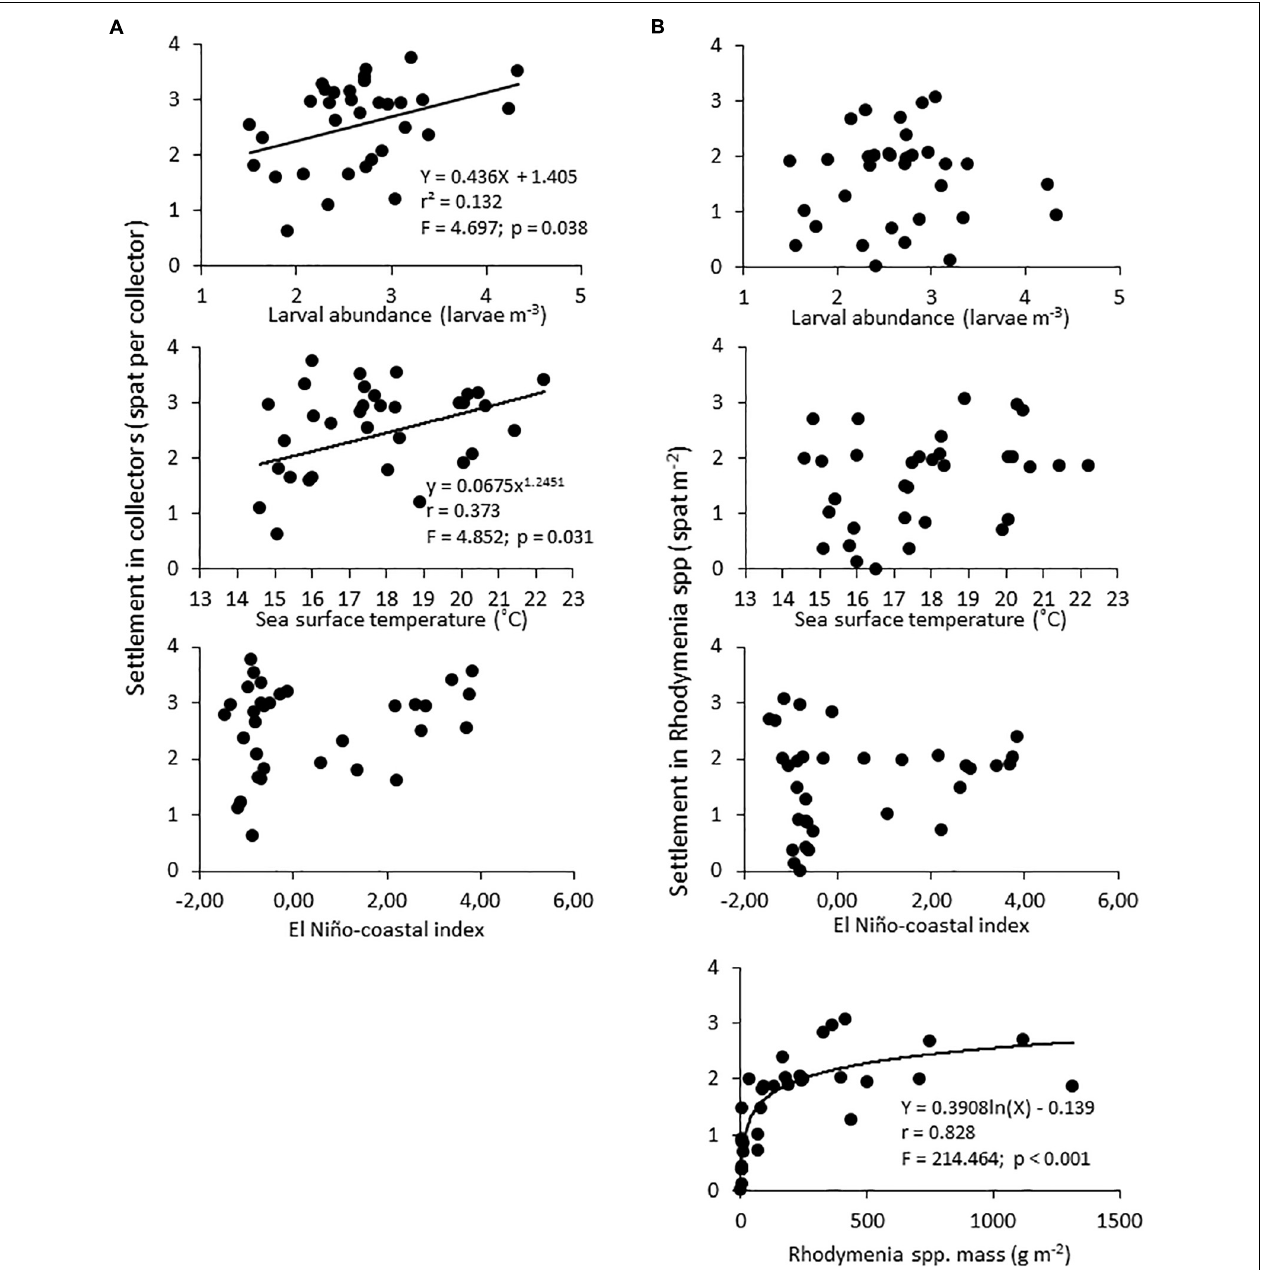
FIGURE 6 | Bivariate scatterplots and model fittings assessing factors affecting the larval settlement of A. purpuratus in artificial collectors (A) and in Rhodymenia spp. (B) . Data on larval settlement were transformed (Log X + 1) to meet the assumption of the models.